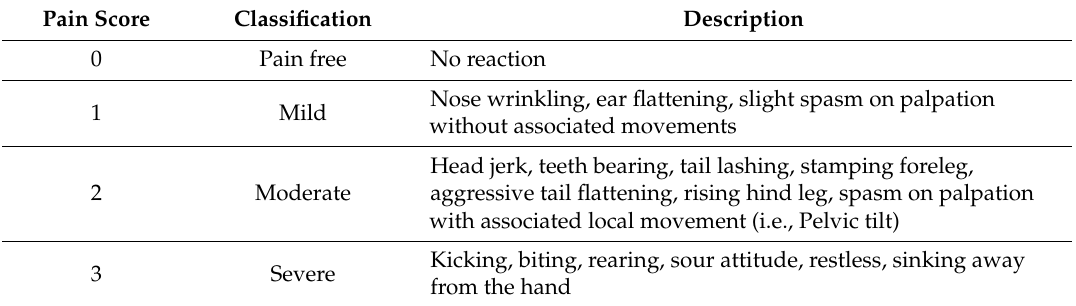
Table A2. Pain scoring